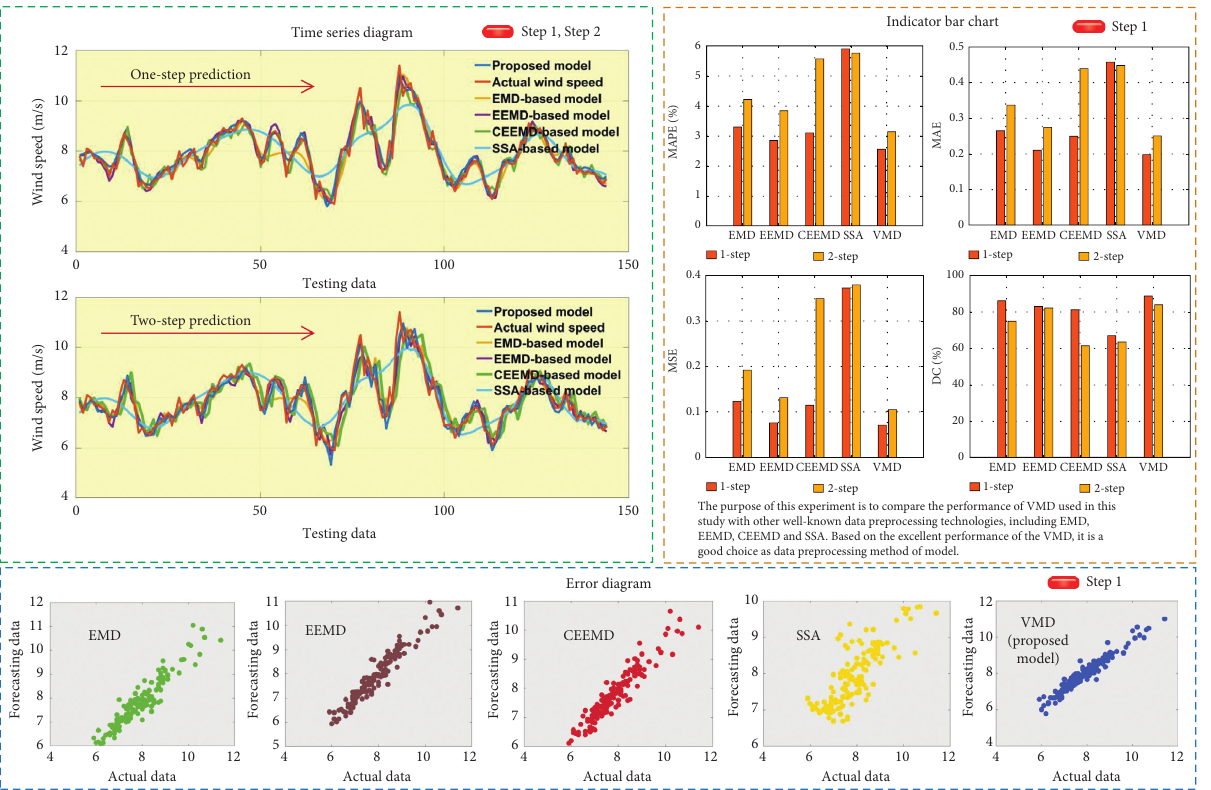
Figure 4: The multistep prediction performance in experiment II for dataset 2. The picture is divided into three parts: one-step and two-step time series prediction chart, one-step error comparison bar chart, and one-step prediction error point